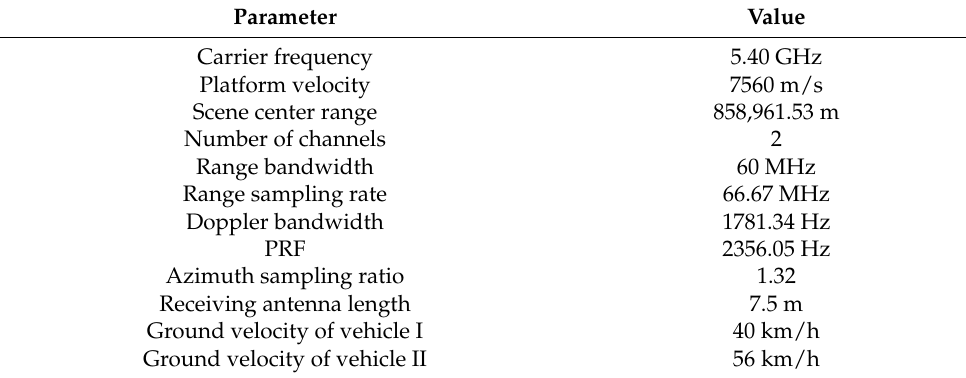
Figure 13. The actual scene of the coordination experiment with controllable vehicles, ( a ) the selected location (the Jingliang Road) for this experiment, and ( b ) the five corner reflectors on the ground near the road, ( c , d ) the two moving vehicles with corner reflectors. Table 6. Main parameters of the Gaofen-3